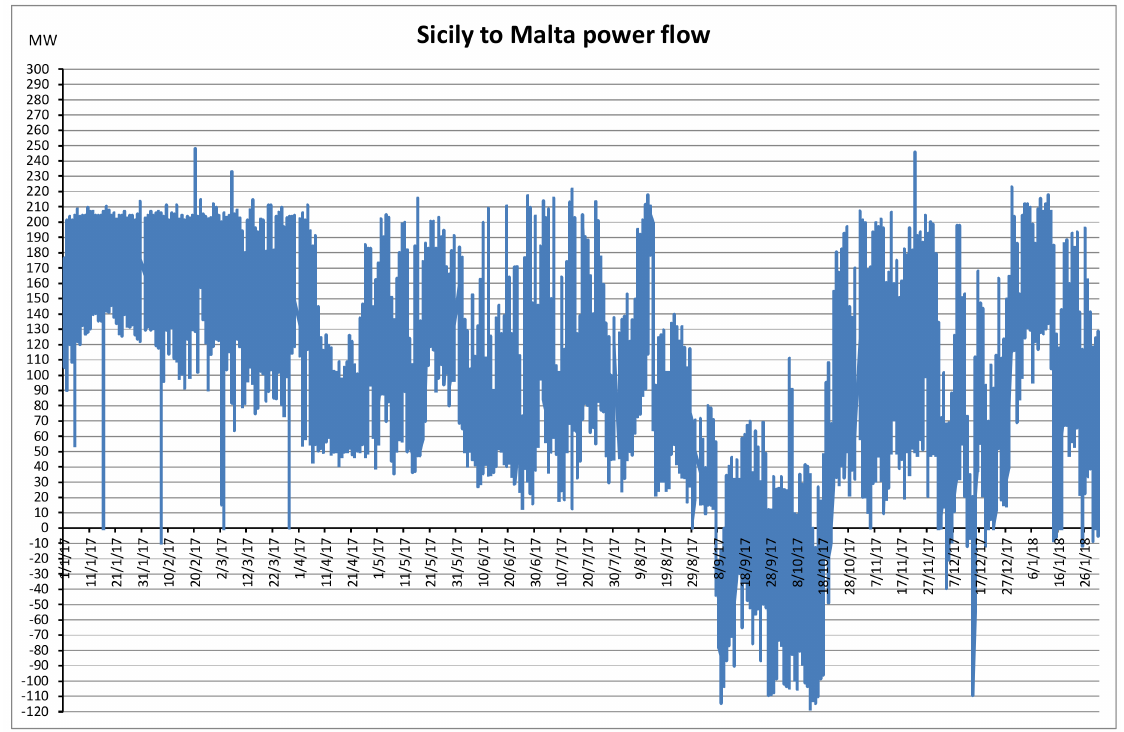
Figure 5. Sicily to Malta power flow from January 2017 to January 2018.